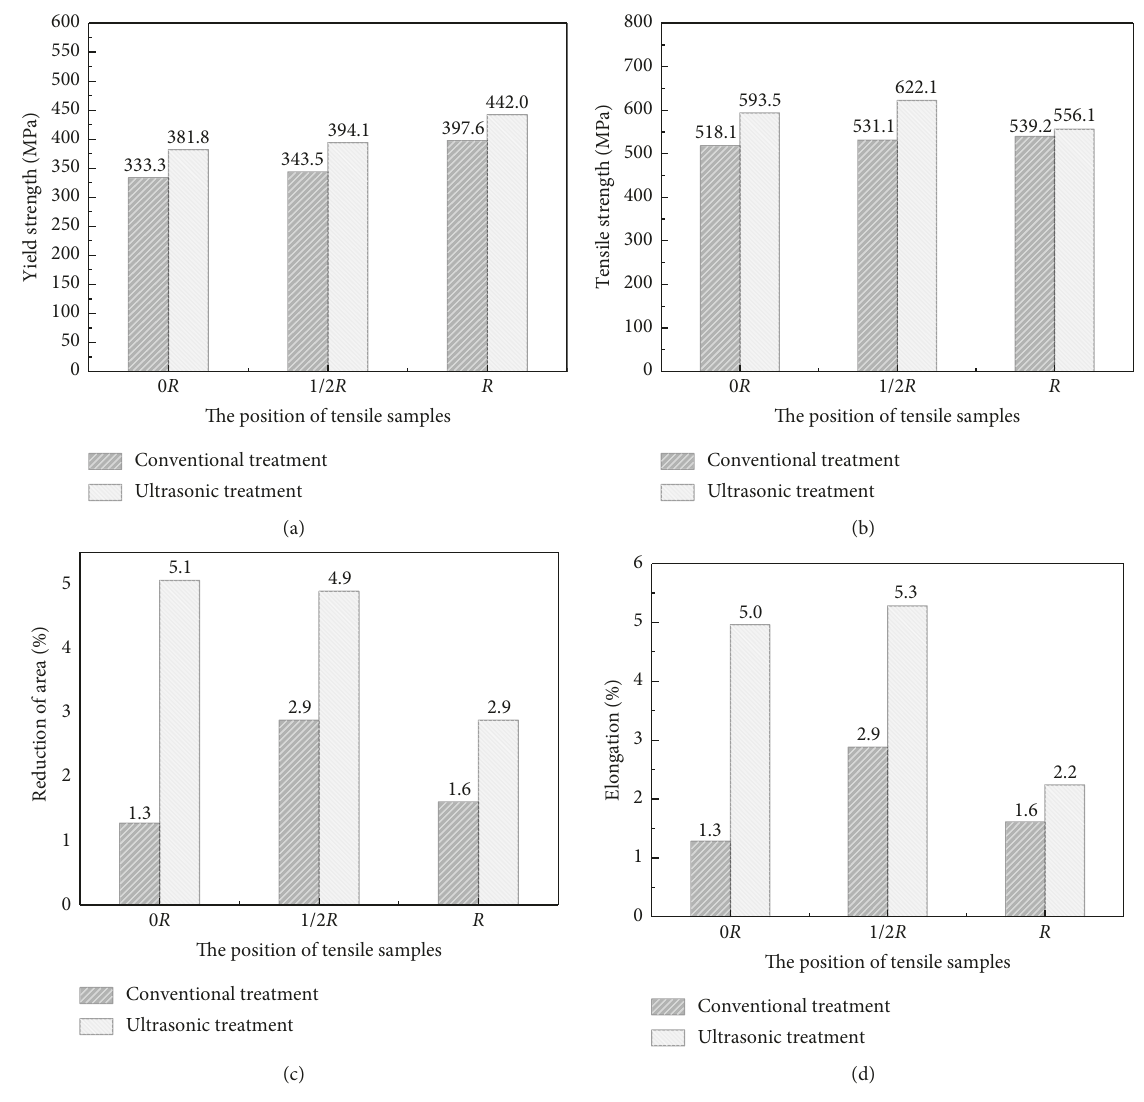
Figure 9: The mechanical properties of 35CrMoV